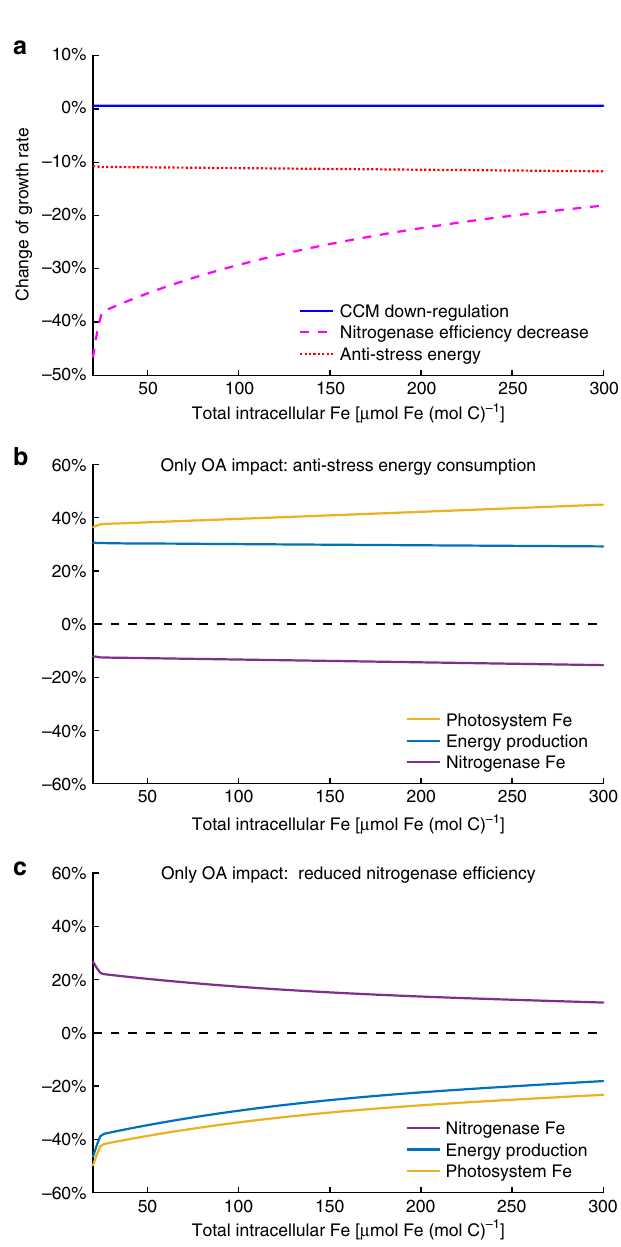
Fig. 4 Comparison of modeled individual impact of ocean acidi fi cation (OA) on Trichodesmium . The pH changes from 8.02 to 7.82 and p CO 2 changes accordingly in the simulations. a Relative changes of growth rate when the model enables each of the OA impacts. Also shown the relative changes of nitrogenase Fe, photosystems Fe, and energy production when the model enables b anti-stress energy or c the reduced nitrogenase ef fi ciency as the